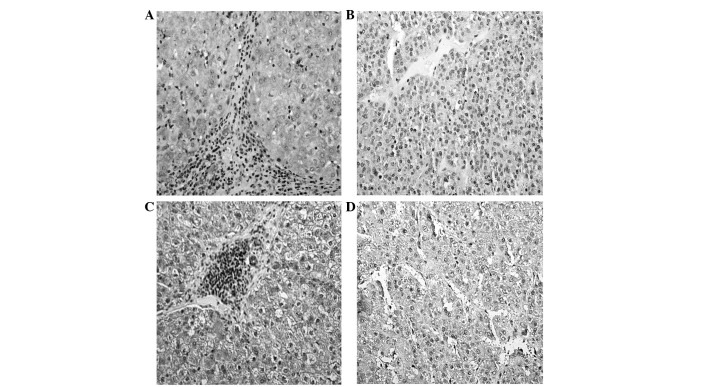
Immunohistochemical staining of SSTR2 and 5 in (A and C) non-tumorous tissues and (B and D) HCC. SSTR2 protein located in the cytoplasm of (A) cirrhotic liver and (B) HCC cells. SSTR5 was also expressed in the cytoplasm of (C) cirrhotic liver and (D) HCC cells. In the cirrhotic liver tissues, a higher intensity of immunostaining was observed compared with the HCC tissues. Original magnification, ×400. SSTR, somatostatin receptor; HCC, hepatocellular carcinoma.